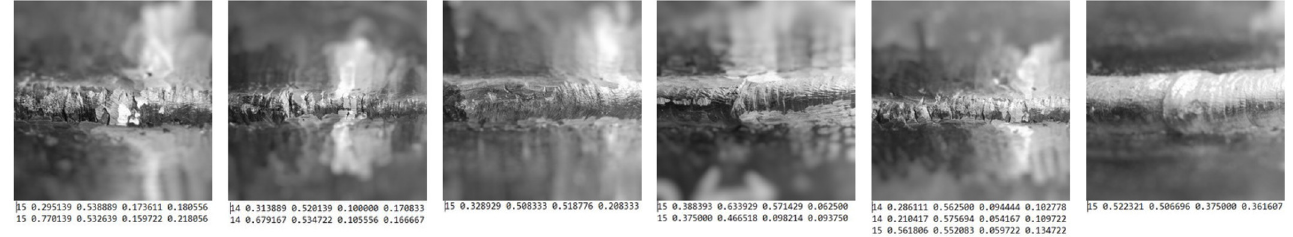
Figure 6. Stages of preliminary processing of image data.